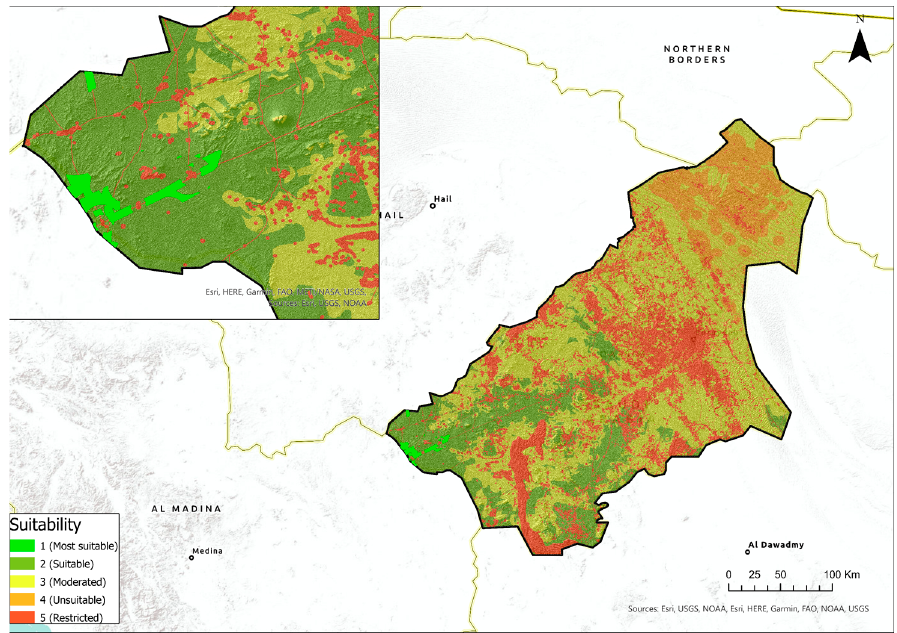
Figure 10. The most suitable areas as a part of the study area.